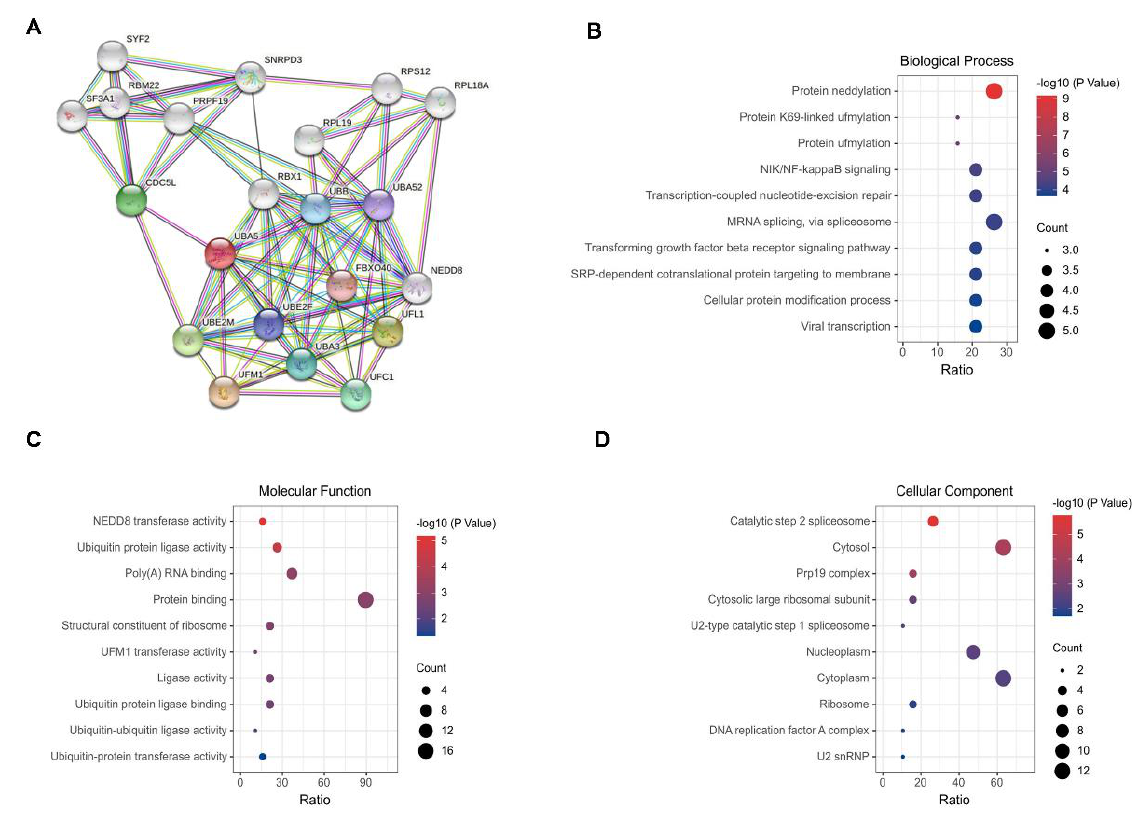
Figure 2. PPI network and GO analysis. ( A ) PPI network of UBA5. ( B ) Biological processes. ( C ) Cellular components. ( D ) Molecular functions. The size of the bubbles indicates the number of involved genes, and lighter colors represent smaller p -values.